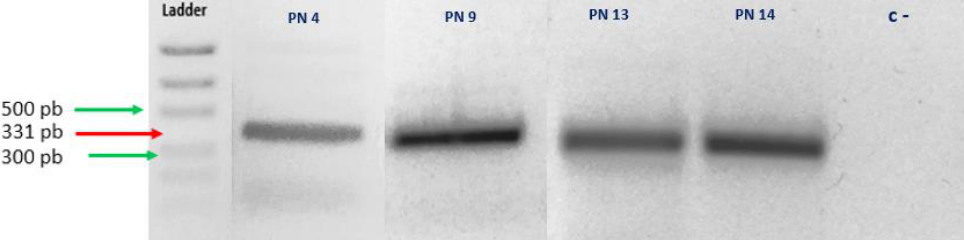
Figure 3. PCR test gel for the amplification of Haplosporidium sp.